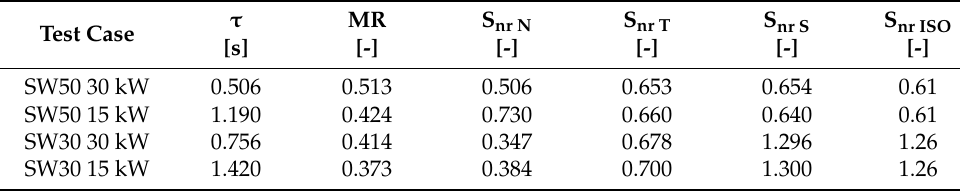
Table 4. Summary of selected monitored variables for 3D reacting flow calculations.